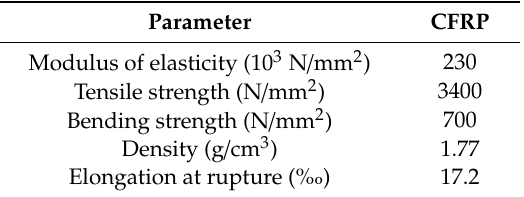
Table 4. Material Properties of steel bars from the manufacturers.